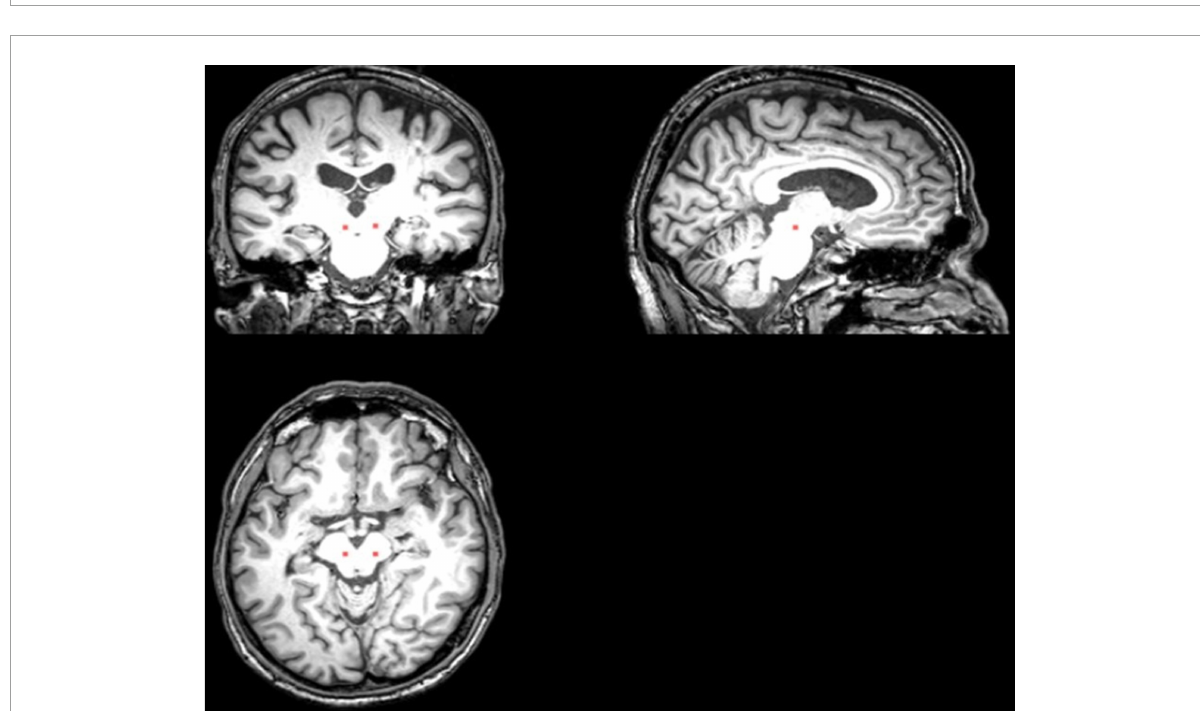
FIGURE2 The placement of the PPN ROI on the T1 sequence (Cai et al., 2018).